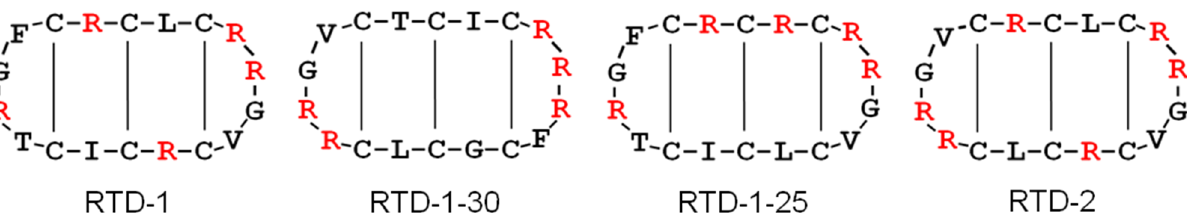
Figure 1. Amino acid sequences of heterodimeric RTD-1 and its two variants and of homodimeric RTD-2. Positively charged residues are marked in red.